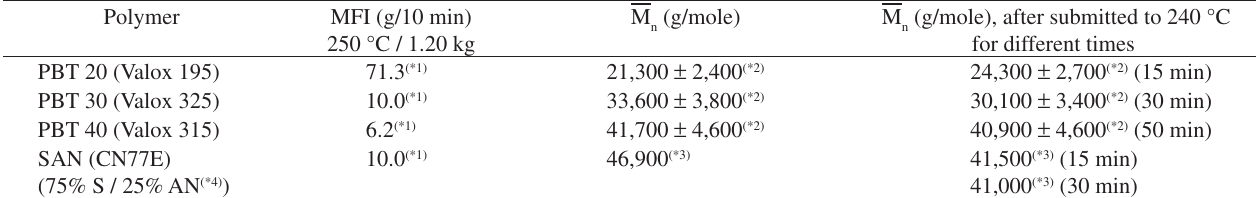
Table 1. Melt flow index and number average molecular weights of the polymers. Polymer